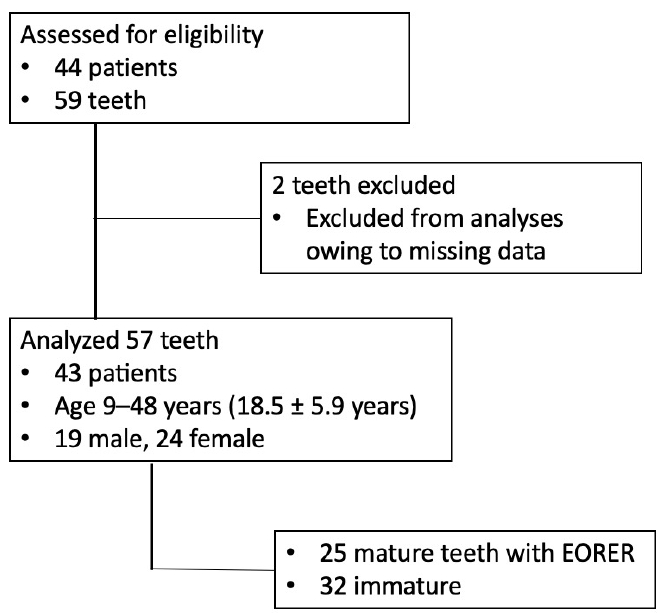
Figure 1. Strobe diagram representing the study patients and